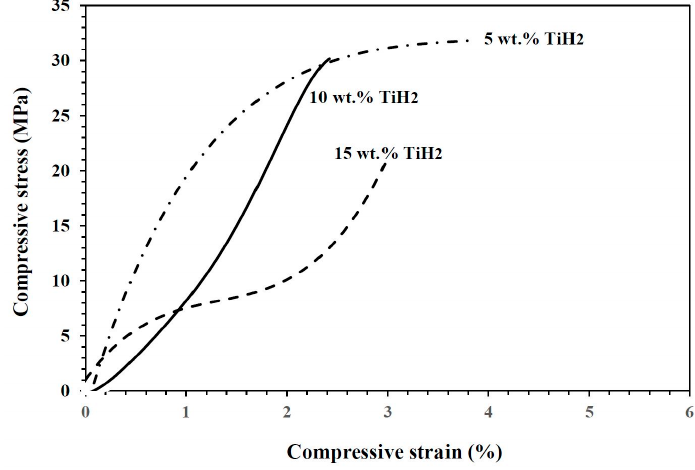
Figure 9. Compressive behavior of Ti matrix syntactic foam with SiC powder weight fraction of 1.5%.